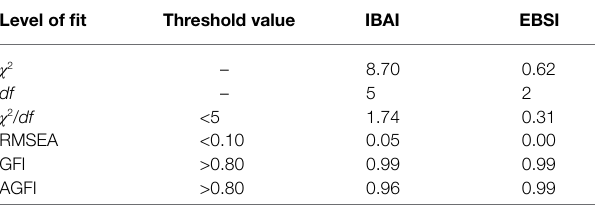
TABLE 1 | First-order CFA.